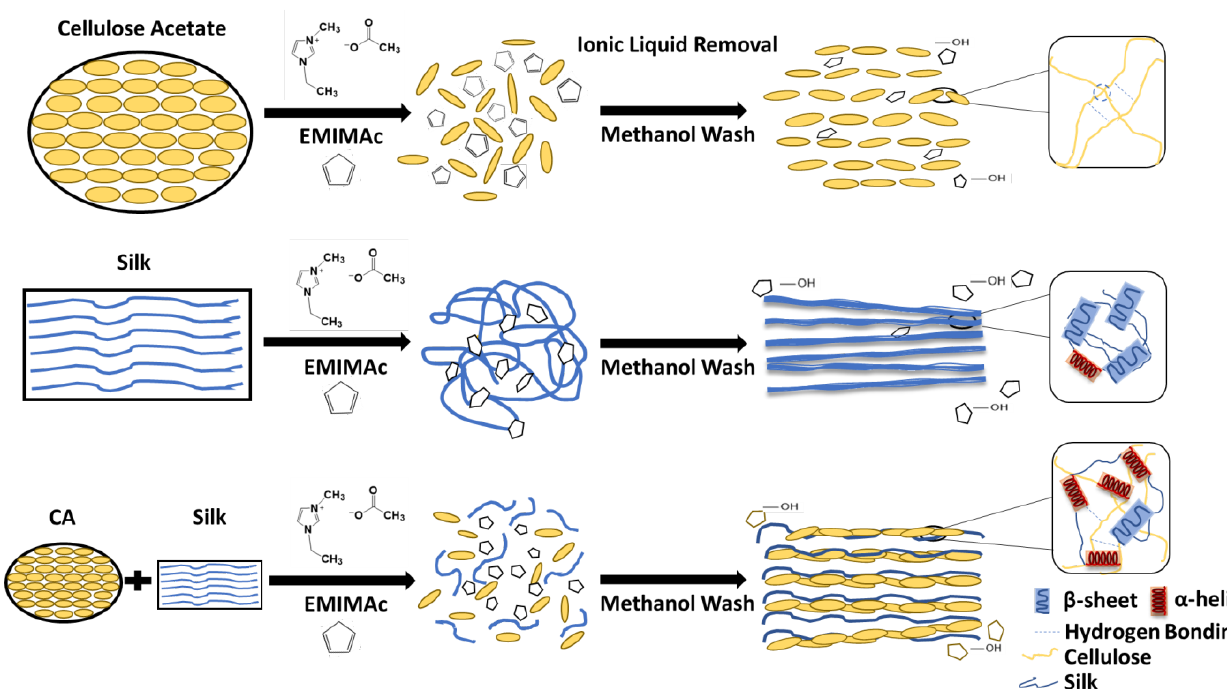
Figure 6. Proposed structural mechanism for the mixing of silk and cellulose acetate using EMIMAc as the solvent.